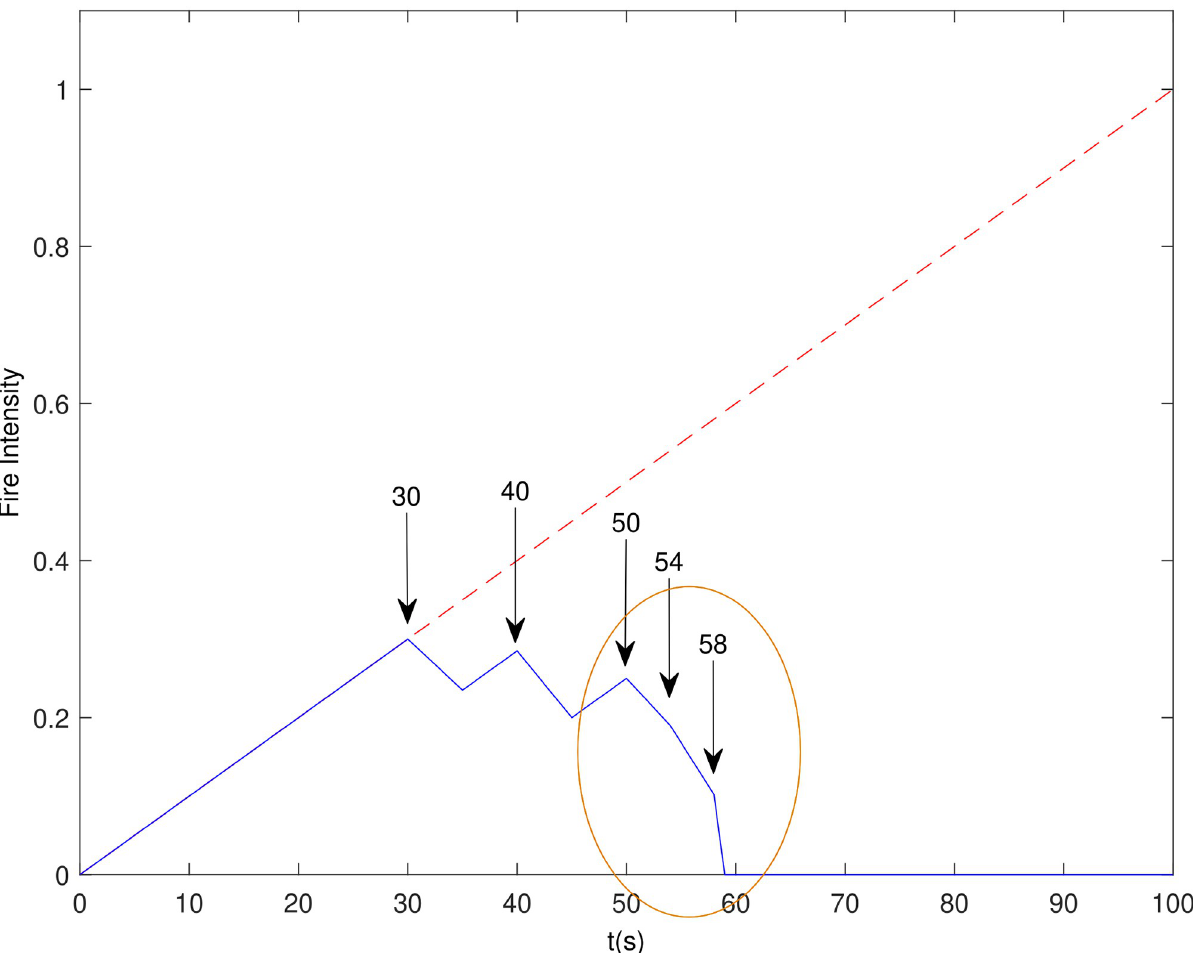
Fig 3. Linear FI model used in firefighting mission. Resource delivery times are indicated by arrows. t